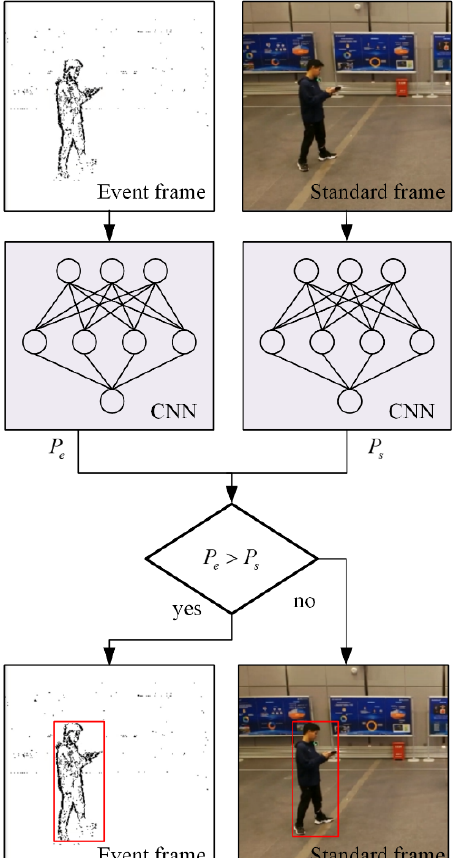
Figure 7. Framework of combined detection based on probability.